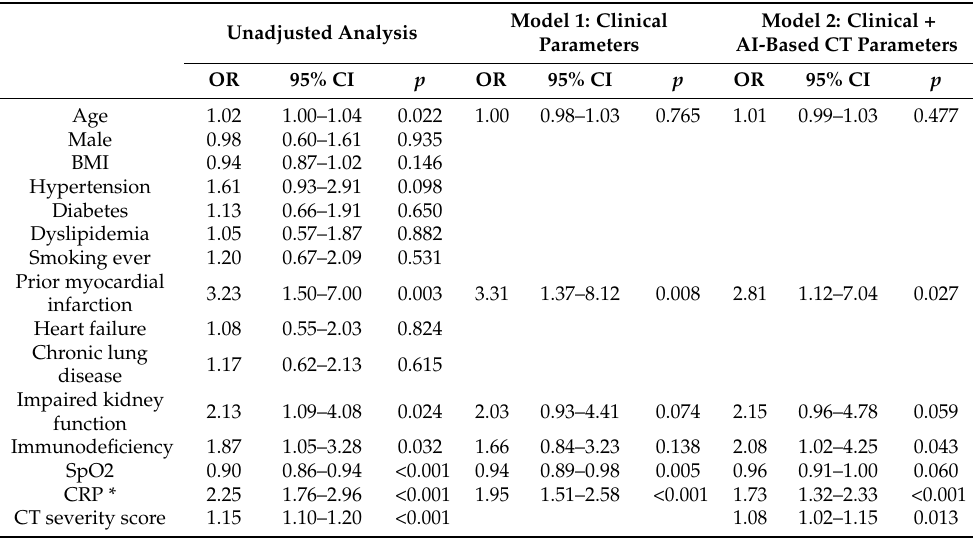
Table 5. Association between clinical and AI-based CT parameters with clinical